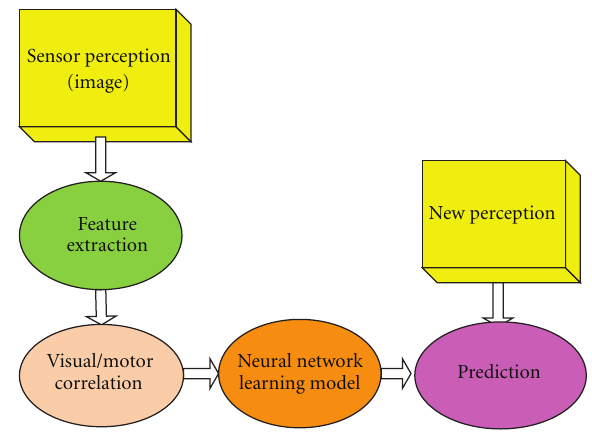
Figure 3: Behavior mobile robot